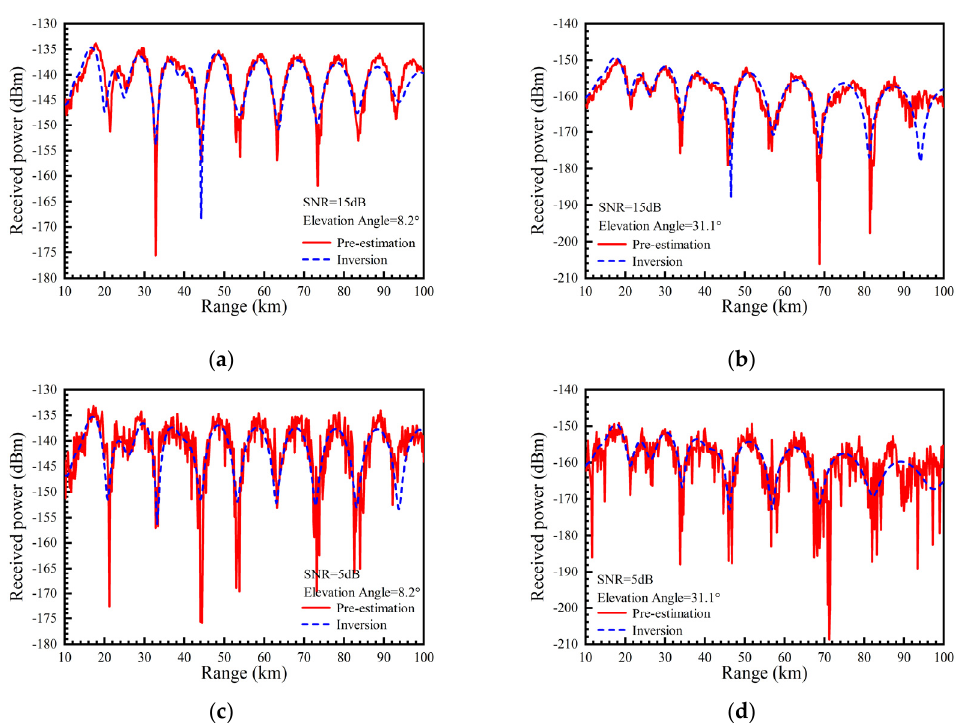
Figure 16. The received powers pre-estimated using the estimated duct parameters and calculated using the inverted duct parameters at different satellite elevation angle and SNR cases: ( a ) the satellite elevation angle is 8.2° and the SNR is 15 dB; ( b ) the satellite elevation angle is 31.1° and the SNR is 15 dB; ( c ) the satellite elevation angle is 8.2° and the SNR is 5 dB; and ( d ) the satellite elevation angle is 31.1° and the SNR is 5 dB.